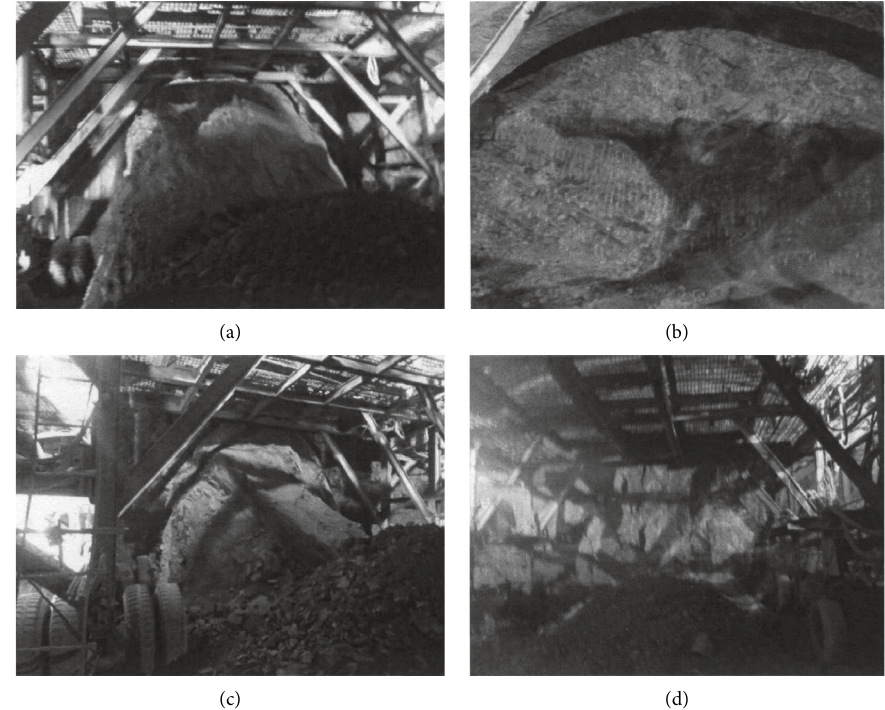
Figure 2: The geological conditions of palm face. (a). The cross-section LK178 +725. (b). The cross-section LK182 +089. (c). The cross- section K0+342. (d). The cross-section RK182 +030.